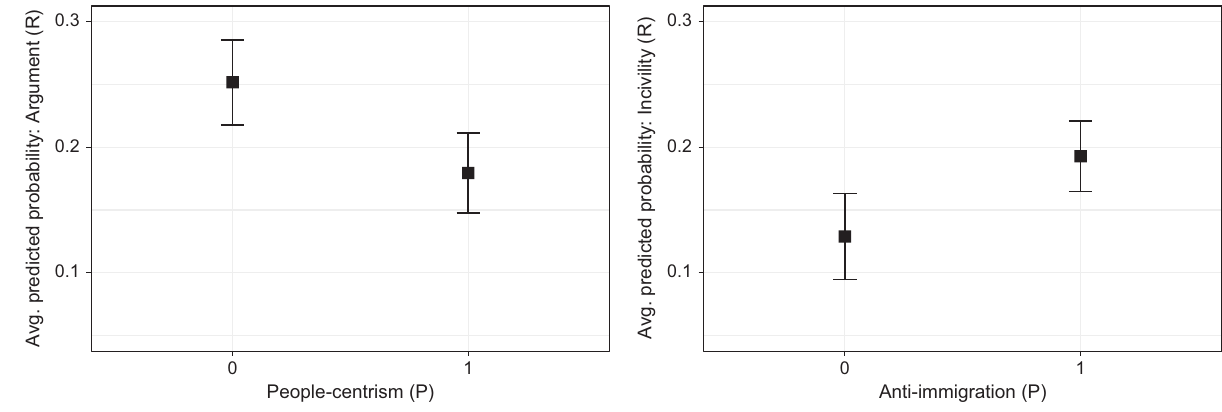
Figure 2. Average predicted probabilities of argumentation and incivility in reply comments. Note: 95% confidence